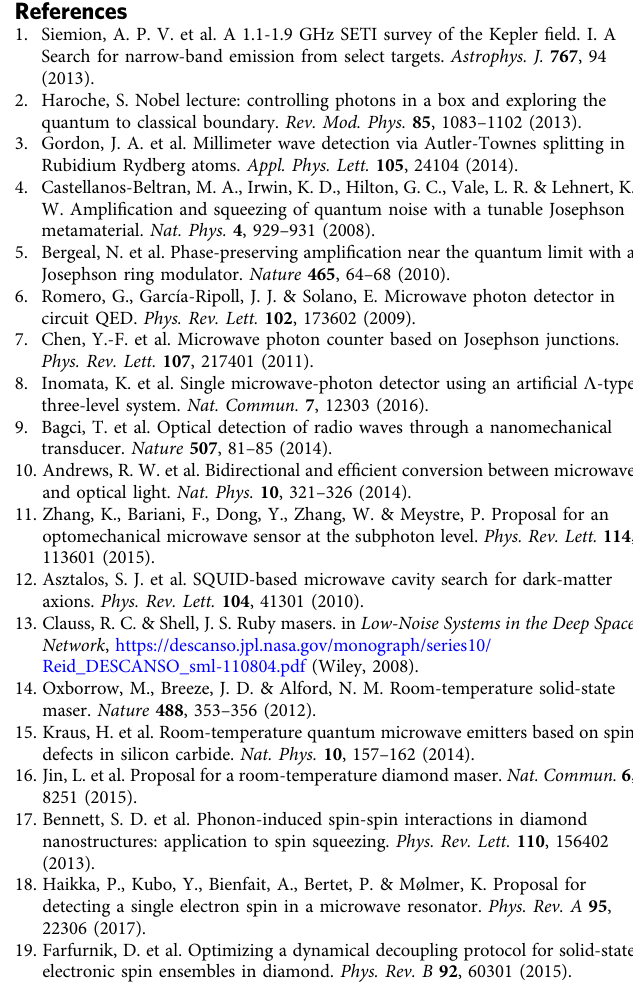
Table 1 Sensitivity of a NV-based sensor for high-frequency signals Single NV, 300 K